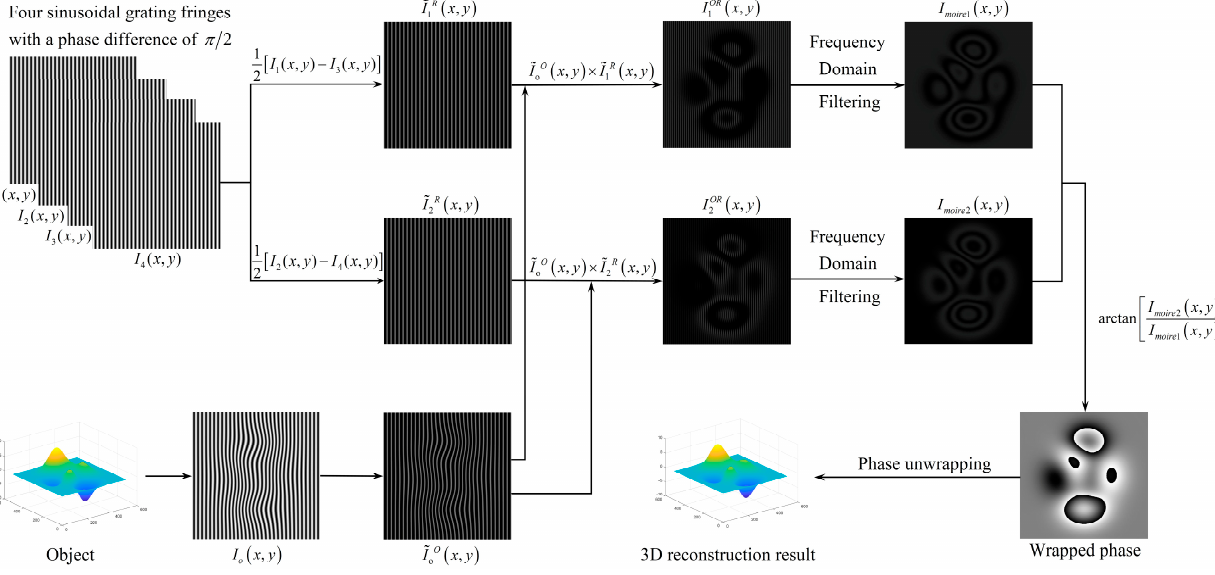
Figure 2. 3D reconstruction of object surface based on MP.